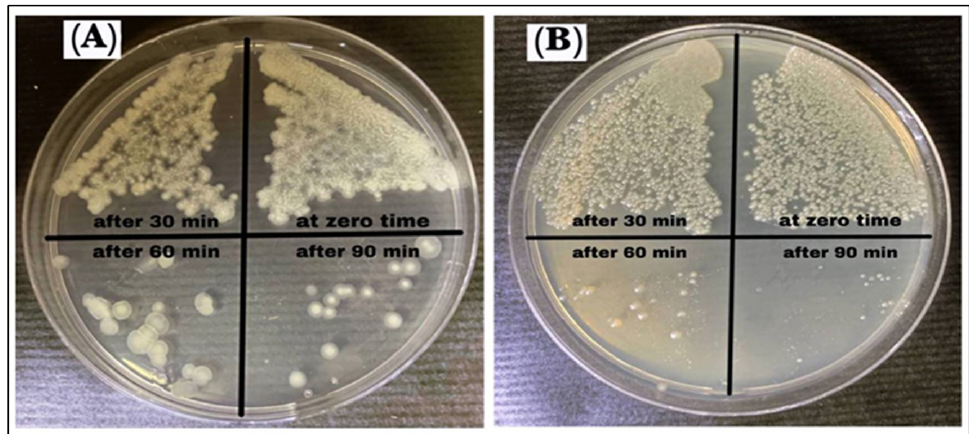
Figure 13. Growth curve assay of AgNPs against ( A ) B. cereus and ( B ) P. mirabilis . Table 6. Growth curve assays of AgNPs against B. cereus and P. mirabilis